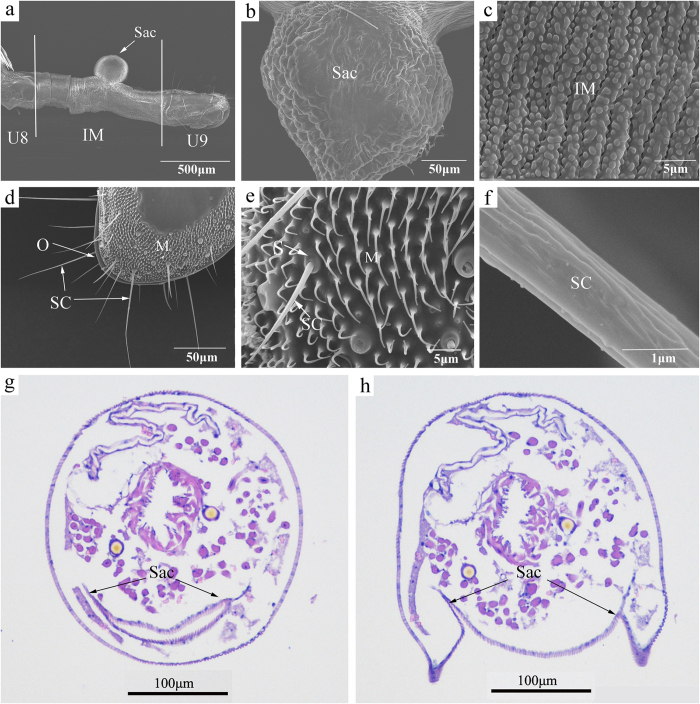
Terminal portion of abdomnden with ovipositor and pheromone gland from female Sitotroga cerealella.(a) Overview of extruded terminal abdominal segments of female S. cerealella under scanning electron microscopy; (b) eversible sac, showing the wrinkles on the surface; (c) surface structure of 8th–9th intersegmental membrane, showing the conspicuous wrinkles and granular protuberances; (d,e) ovipositor sensilla of S. cerealella, showing the features of sensilla chaetica and microtrichia; (f) surface structure of SC; (g,h) histological sections through the glandular region with the sac in retracted position and the sac bulged out, respectively. Purple indicates cytoplasm, and blue represents cell nucleus. U8, 8th uromere; U9, 9th uromere; IM, intersegmental membrane of 8th–9th uromeres; O, ovipore; SC, sensilla chaetica; S, socket; M, microtrichia.